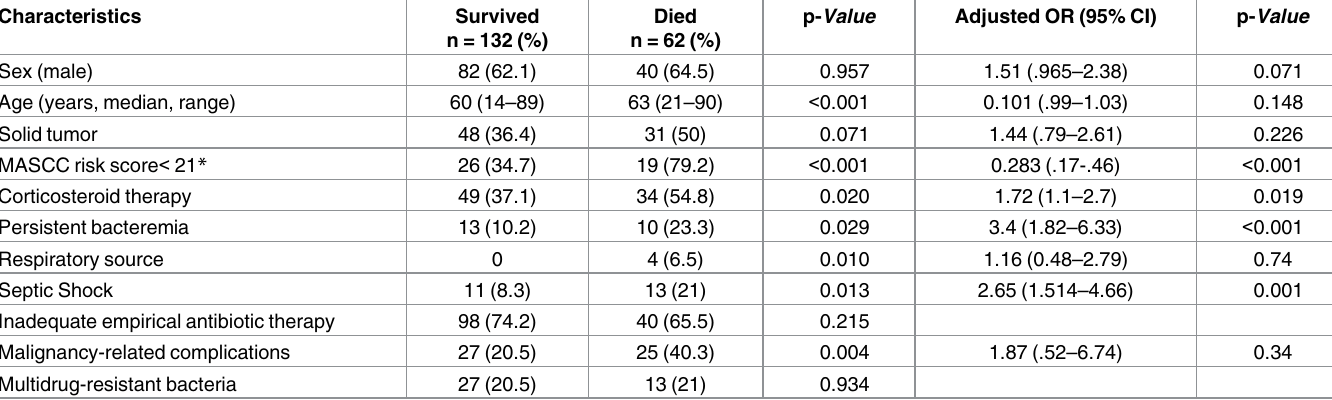
Table 5. Risk factors for overall case-fatality rate by univariate and multivariate analysis.